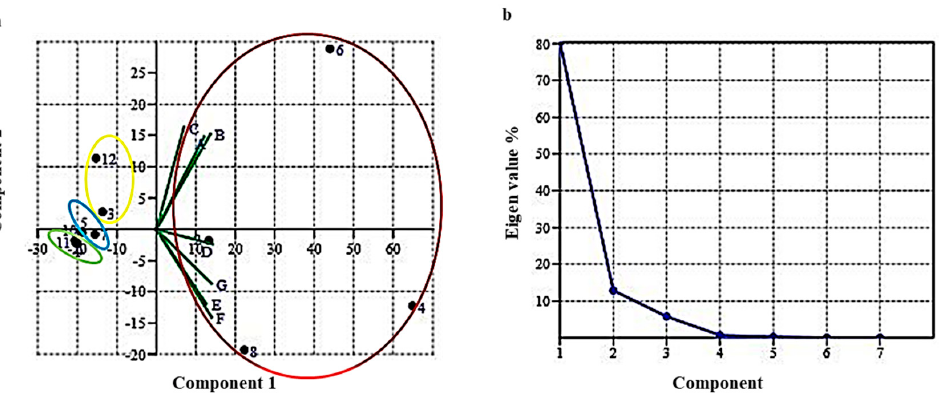
Figure 2. Graphical representation of principal component analysis (PCA) showing the matrix of two variables ( a ) Scatter plot between X -axis (PC1) and Y -axis (PC2) showing the distribution of 12 different compound and seven climate zones of North Western Himalayas. Where 12 different componds were clustered into four circles and denoted as red, yellow, blue and green circles and ( b ) Scree plot showing eigen values at Y -axis and number of factors/components at X -axis. The PC1 have shown the highest positive scores for the essential oil compounds viz.,